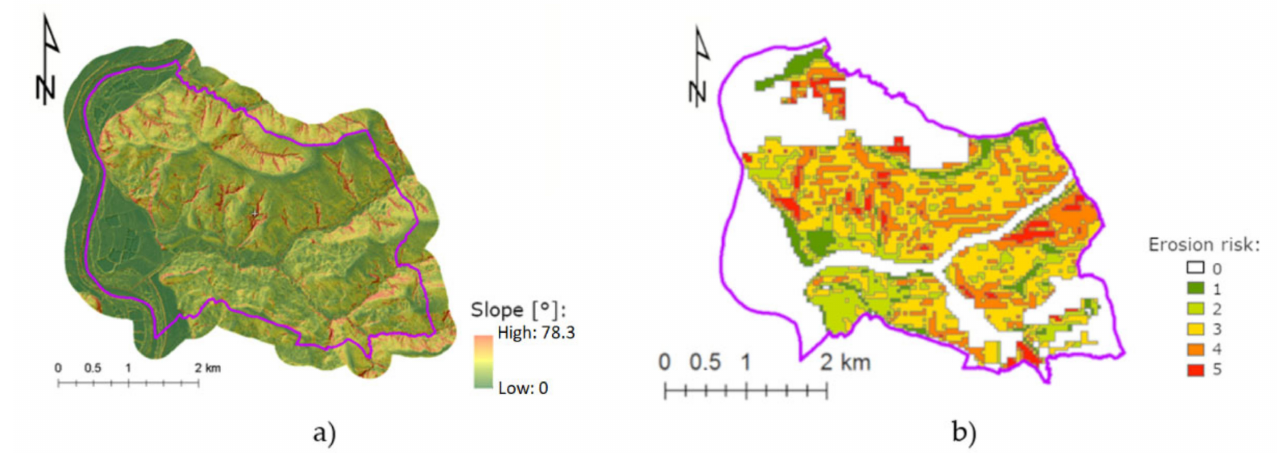
Figure 2. Janowice research area: slope map with hill shade effects (data source: ALSdigital terrain model (DTM) processing— 1 m × 1 m spatial resolution) ( a ) and water erosion risk based on The Institute of Soil Science and Plant Cultivation (IUNG) expert classification from level 0—no risk to level 5—very high risk and 40 m × 40 m spatial resolution ( b ).